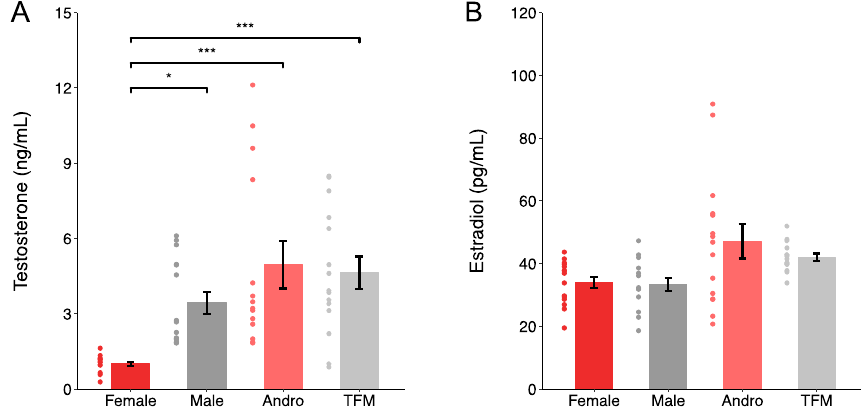
Figure 1. Testosterone is significantly lower in females whereas estradiol levels are similar between sex groups. ( A ) Bar graph shows higher testosterone levels in all sexes, except for female rat pups (F: 1.01 ± 0.09 ng/mL, n = 15 rats from 3 litters; M: 3.44 ± 0.44 ng/mL, n = 15 rats from 3 litters; A: 4.96 ± 0.95 ng/ml, n = 14 rats from 4 litters; TFM: 4.64 ± 0.65 ng/Ml, n = 15 rats from 5 litters; One-way ANOVA with Tukey’s post hoc analysis, F × M: p = 0.028; F × A: p < 0.001; F × TFM: p < 0.001). ( B ) Bar graph shows no significant differences in levels of estradiol between all groups (F: 34.0 ± 1.81 pg/mL, n = 15 rats from 3 litters; M: 33.4 ± 2.14 pg/mL, n = 15 rats from 3 litters; A: 47.1 ± 5.47 pg/mL, n = 14 rats from 4 litters; TFM: 42.1 ± 1.18 pg/mL, n = 15 rats from 5 litters; One-way ANOVA with Tukey’s post hoc analysis, F × M: p = 0.995; F × A: p = 0.080; F × TFM: p = 0.140).